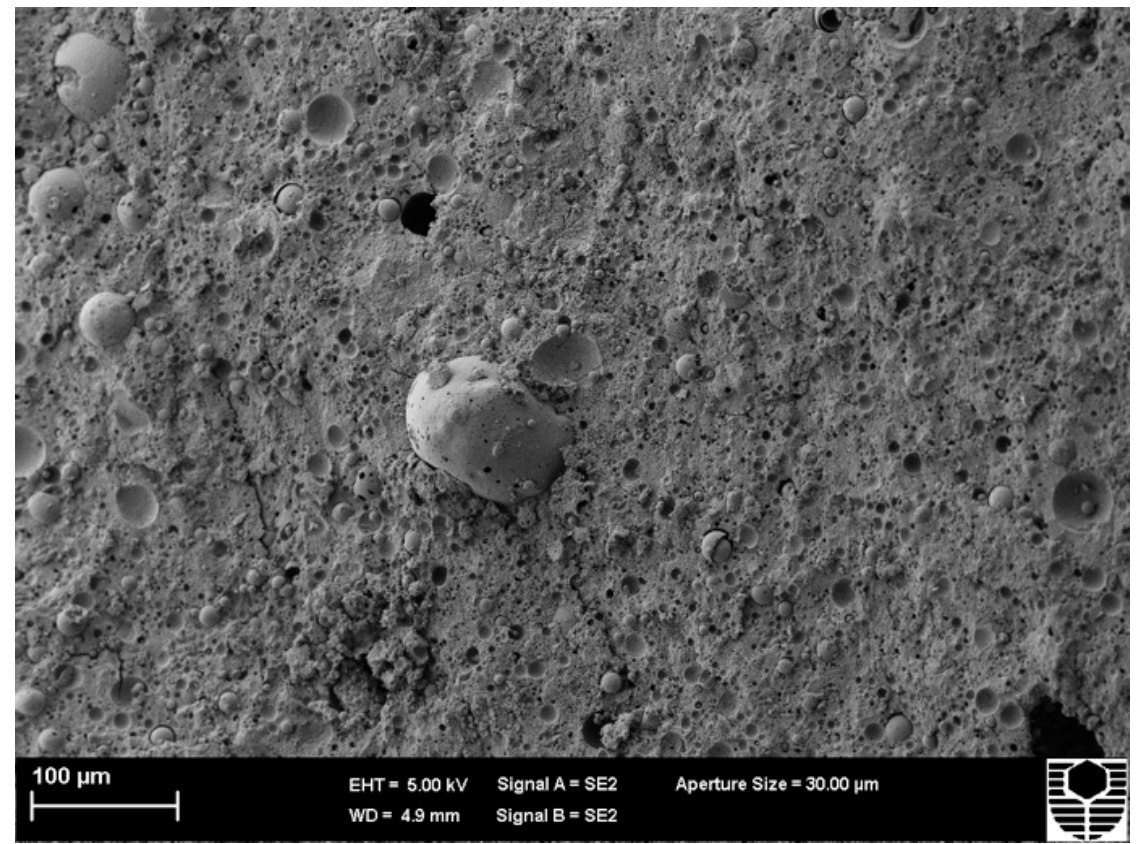
Figure 7. Microstructure of Mix 1 for FA-based geopolymer.